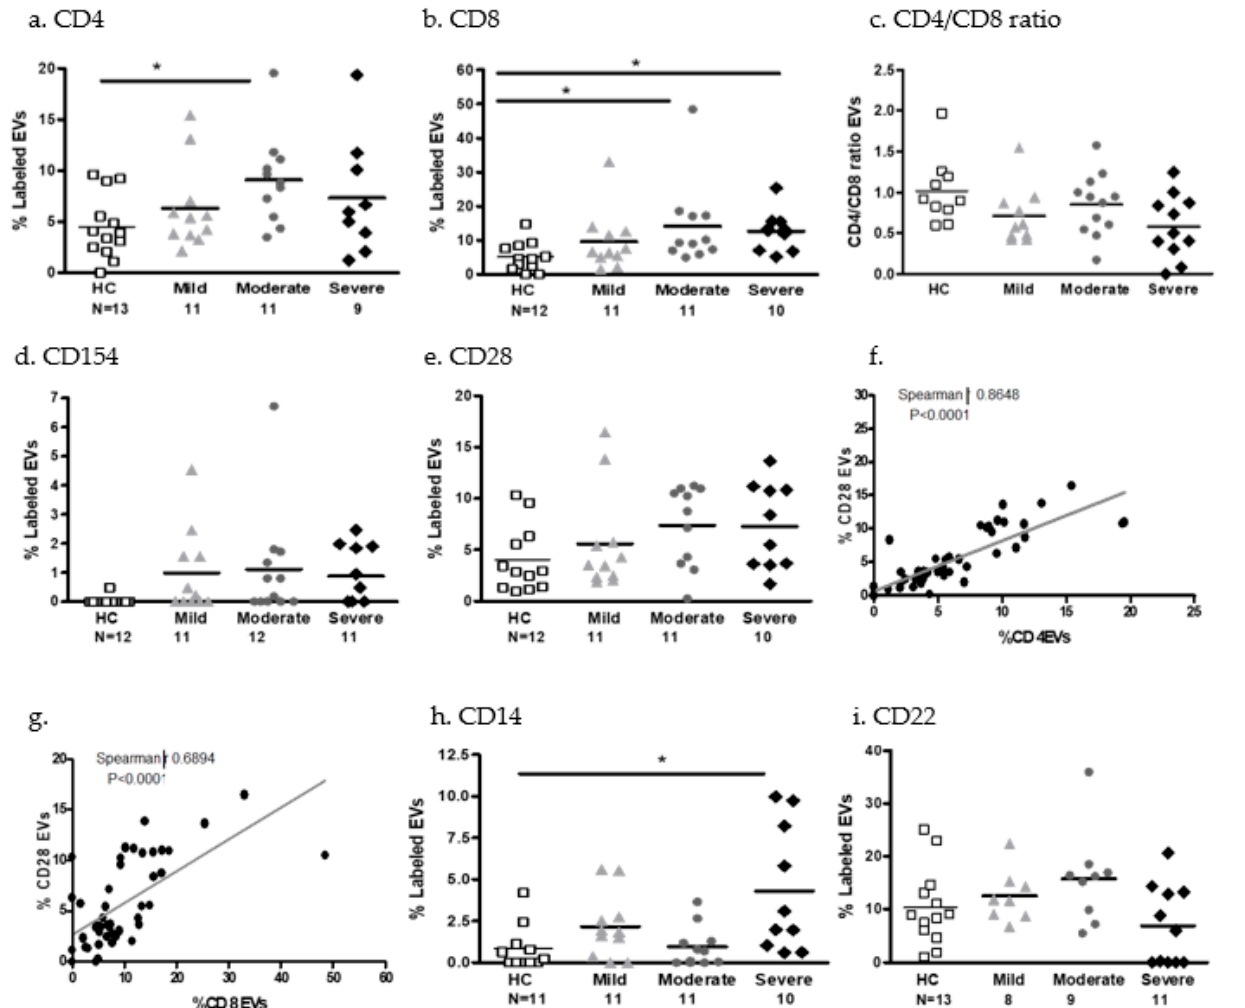
Figure 6. Immune cell marker expression on EVs. The expression of immune cells markers on EVs derived from PPP of HCs and mild, moderate, and severe COVID-19 patients. Data are expressed as percentage of labeled EVs in the EXo gate (as described in Figure 2a) analyzed using a CytoFLEX LX flow cytometer. The graphs show CD4+ helper T cell markers ( a ), CD8+ cytotoxic T cell markers ( b ), the ratio of CD4/CD8 EVs ( c ), CD154 (CD40 ligand) primarily expressed on activated T cells ( d ), and CD28 expressed on T cells which provide co-stimulatory signals for T cell activation and survival ( e ). Correlation between expression of CD28 and CD4 and CD8-labeled EVs ( f , g ). CD14, monocyte and macrophage marker ( h ); CD22 B cell marker ( i ). * p <